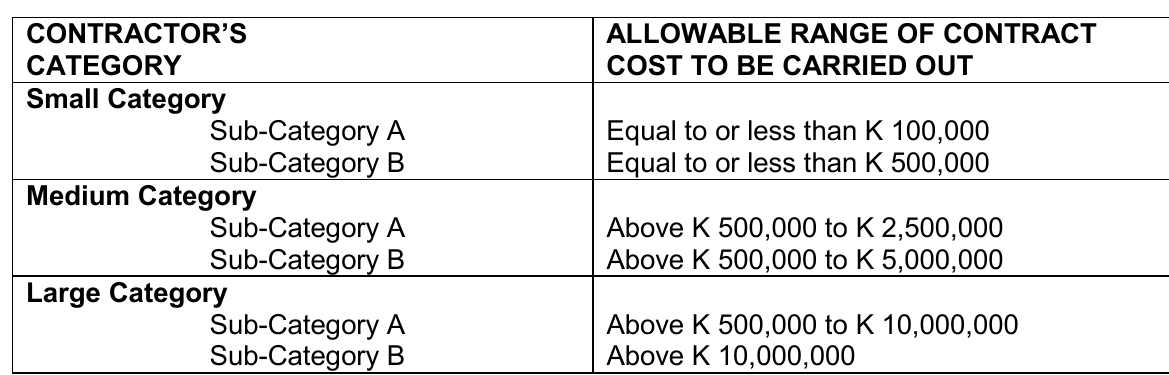
Table 1: Contractor’s category and allowable range of contract cost (Source: Construction Industry Unit,